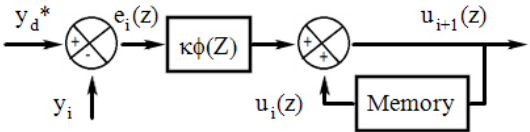
Figure 7. Basic model of ILC block